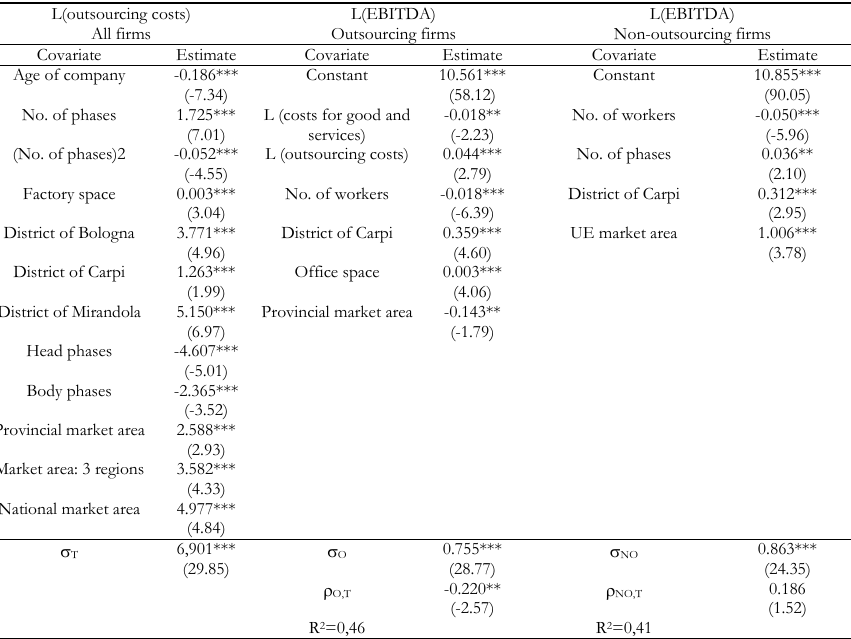
Results for firms with employees: effects on Per-Capita Value